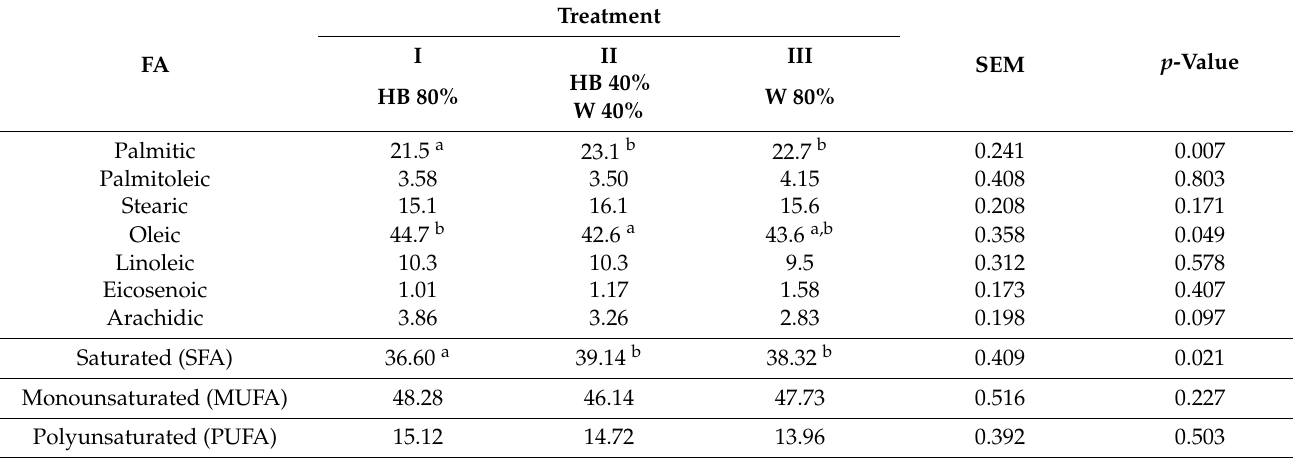
The profile of free FA in meat of the fattening pigs is shown in Table 2. Meat collected from animals assigned to group I, receiving dietary 80% HB inclusion, was characterised by the highest content of oleic acid (44.7%) ( p = 0.049) but at the same time the lowest concentration of palmitic acid (21.5%) as compared with the other two experimental groups ( p = 0.007). Table 2. Fatty acid composition (as % of total FAME*) in meat of the fattening pigs.